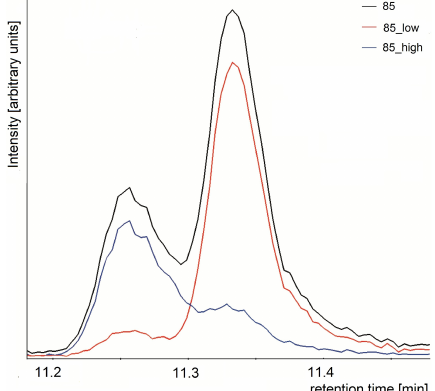
Figure 5. A chromatogram of an unidentified hydrocarbon peak (smaller one) eluting slightly earlier than the higher Trichloromethane peak. The nominal mass 85u (black) shows a double peak. By choosing the lower mass range (84.7u to 85.0u; red) a lower signal for the unidentified hydrocarbon peak is ob- served, and by choosing the higher mass range (85.0u to 85.3u, blue) a lower signal for the Trichloromethane peak is